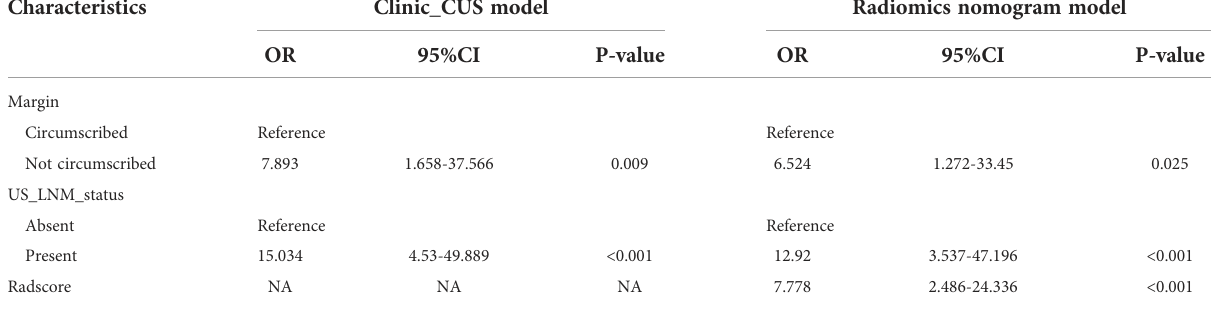
TABLE 6 Multivariate logistic analysis for the risk factors of LVI.